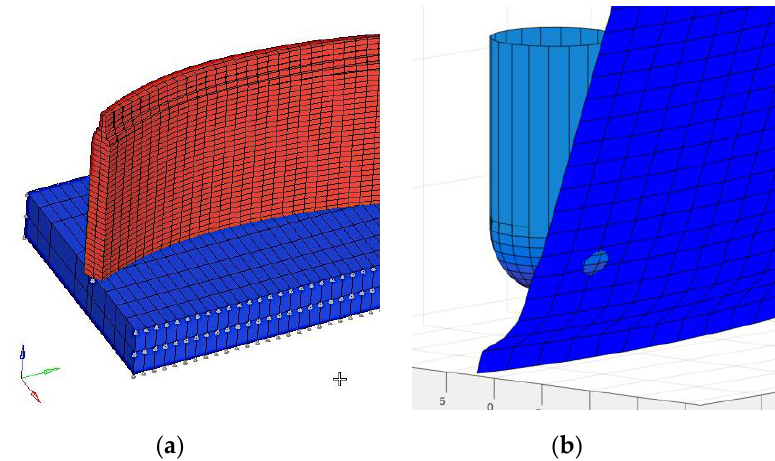
Figure 7. Finite element (FE) model updating phase: ( a ) FE model ( b ) tooltip position.